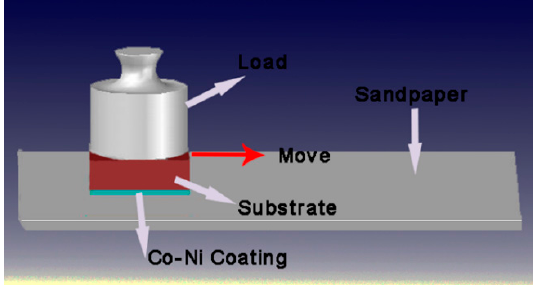
Figure 5. A scheme for linear abrasion test.